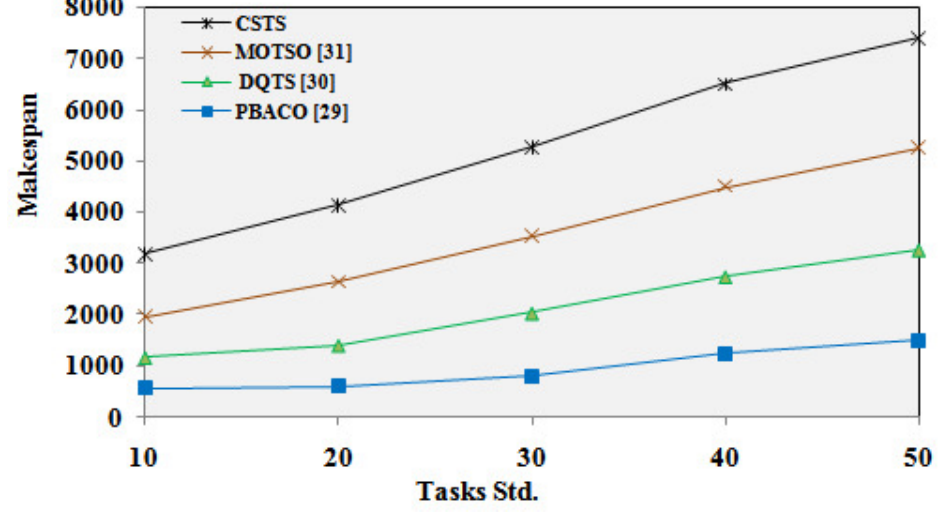
Figure 6. Makespan with task standard format.